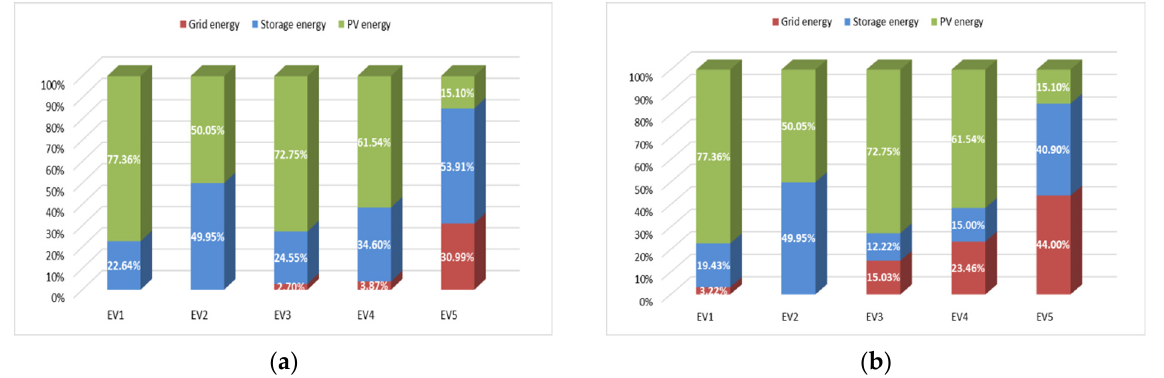
Figure 15. EV energy distribution in ( a ) “Sim w/o opt” and ( b ) “Sim with opt”—case 3.